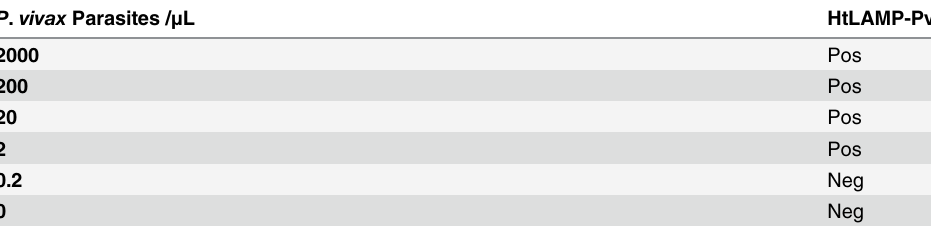
to cross-reactivity of the VIV2 primers with P . knowlesi , with 97% sequence homology at the cox1 gene between P . vivax and P . knowlesi . When P . knowlesi samples were excluded from the analysis, the specificity was 100% compared with both multiplex PCR and microscopy (Table 6). Sensitivity and specificity of HtLAMP-Pv in asymptomatic, reactive active case detection community control patients HtLAMP-Pv was compared with nested PCR for red cell pellet samples from asymptomatic, microscopy negative community controls from the malaria endemic district of Kota Marudu, Sabah, Malaysia. The sensitivity of HtLAMP-Pv was 71% (95% CI 29 – 96; 5/7) and specificity was 93% (95% CI 87 – 97; 98/105) compared with PCR. Table 4. Analytical sensitivity of HtLAMP-Pv on microscopy-determined whole blood P . vivax dilution series. The limit of detection HtLAMP-Pv is 2 parasites/ μ L, performed in duplicate and where both dupli- cates were